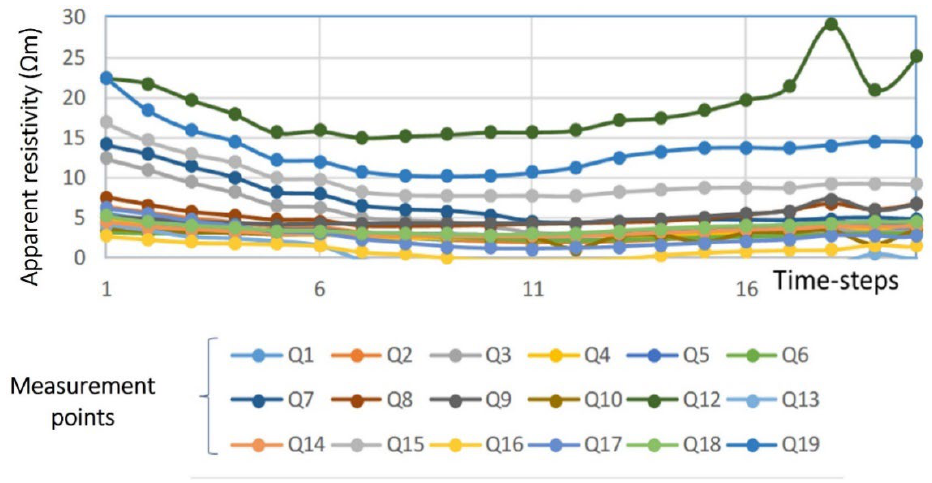
Figure 5. Subset of data (in terms of apparent resistivity) taken at several measurement points, in the set-up of Figure 4, over 20 time steps. Q is quadrupole.